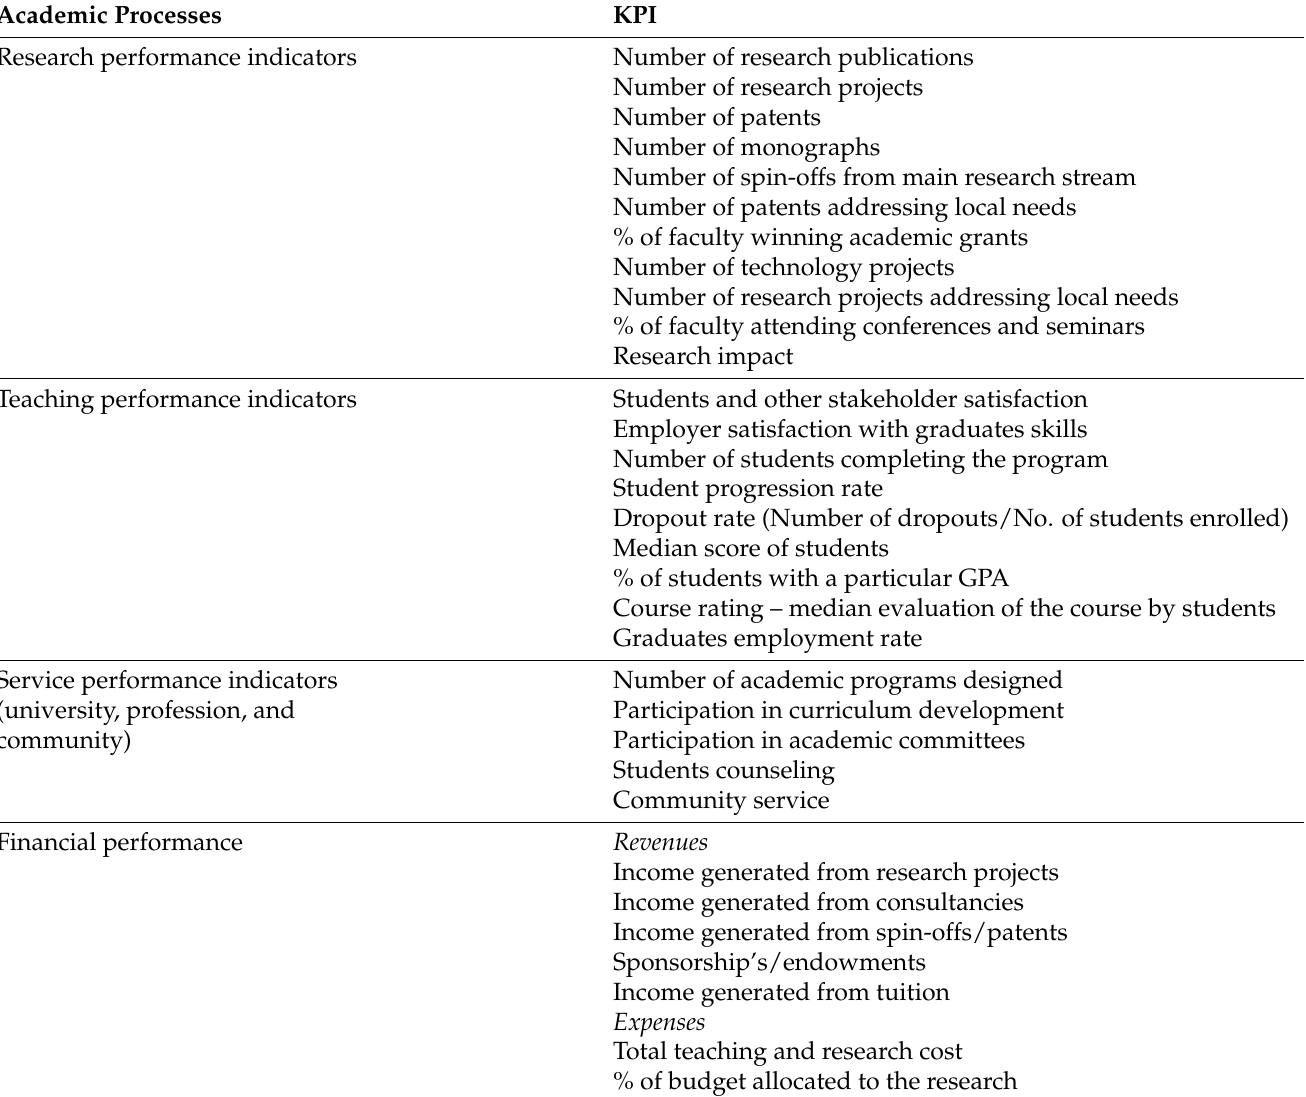
Table 6. Key performance indicators (KPI) in higher education (HE) from Asif and Cory [41] (p.